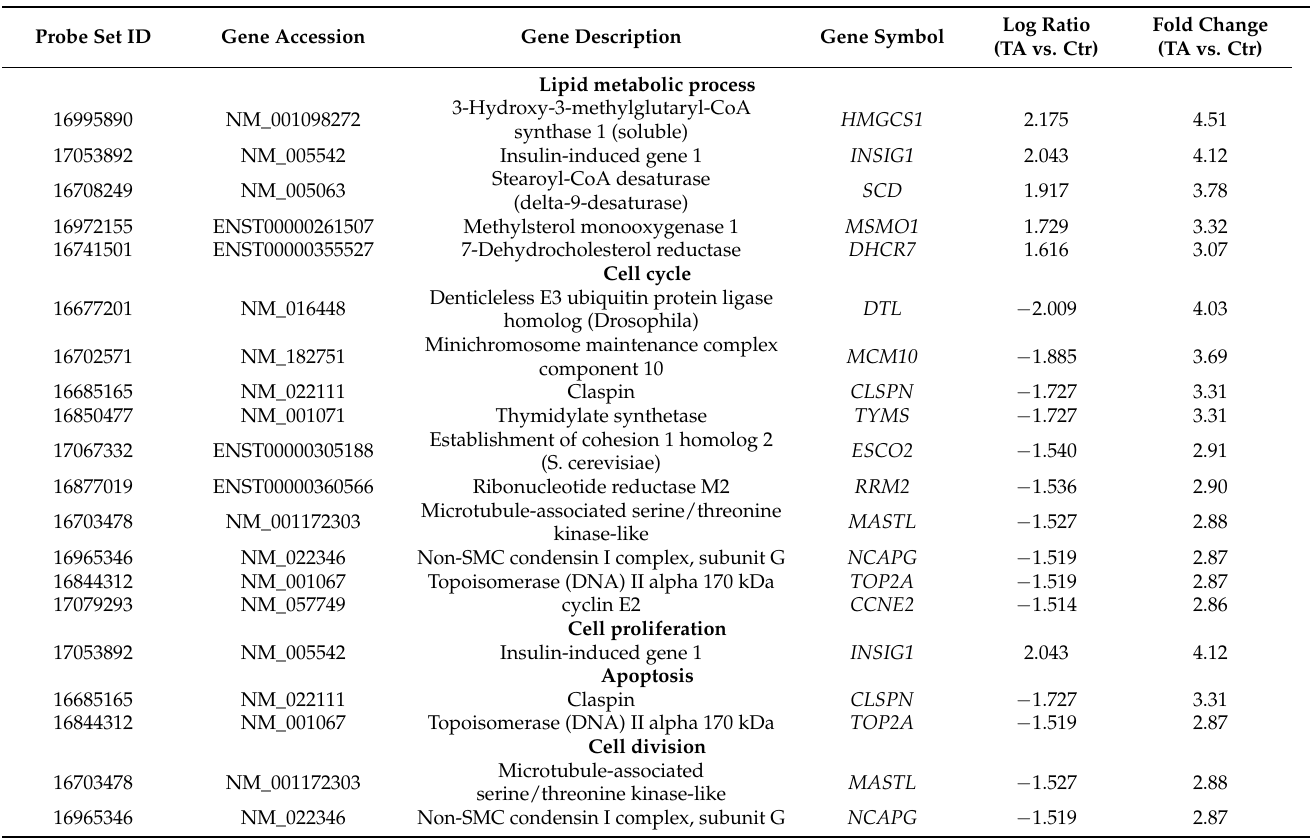
Table 2. The 22 genes most differentially expressed in TA3 treatment compared to untreated BxPC-3 cells were selected based on microarray